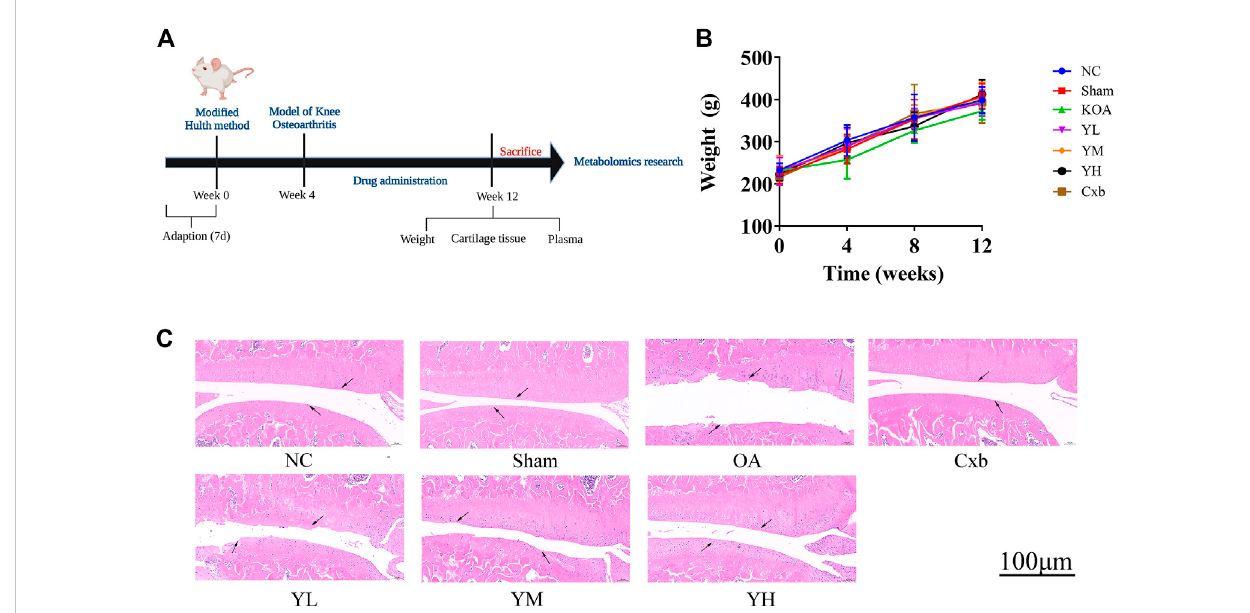
Effects of YQYXF in OA rats. (A) Time fl ow chart. (B) Effects of YQYXF on body weight. (C) Cartilage tissue HE staining. NC: normal control group, sham: sham operation group, OA: model group, Cxb: celecoxib, YL: low-dose groups of YQYXF, YM: medium-dose groups of YQYXF, YH: high-dose groups of YQYXF.